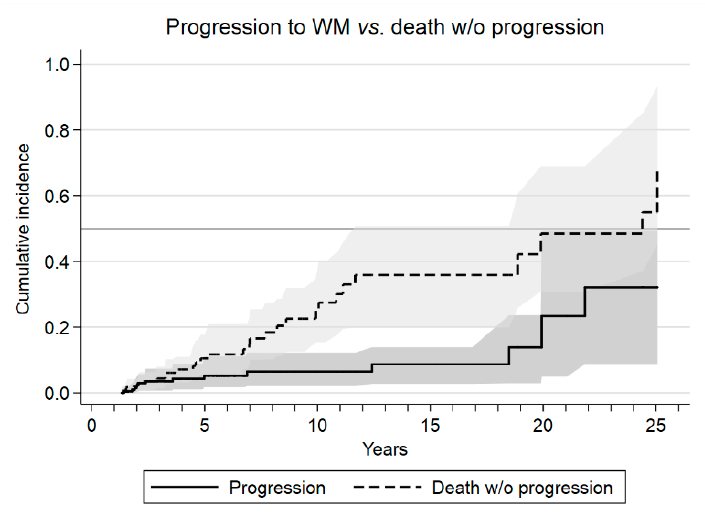
Figure 1. Relative risk of progression to Waldenström macroglobulinemia (WM) or death without ( w / o ) progression evaluated as cumulative incidence in the framework of competing events.